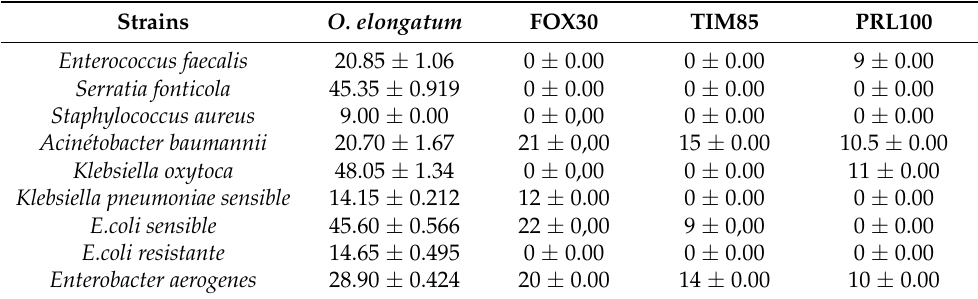
Table 3. Antibacterial activity of the EO of O. elongatum and antibiotics (FOX30,TIM85, PRL100) (agar diffusion method) expressed in terms of inhibition zone (mm) [mean ± standard deviation].